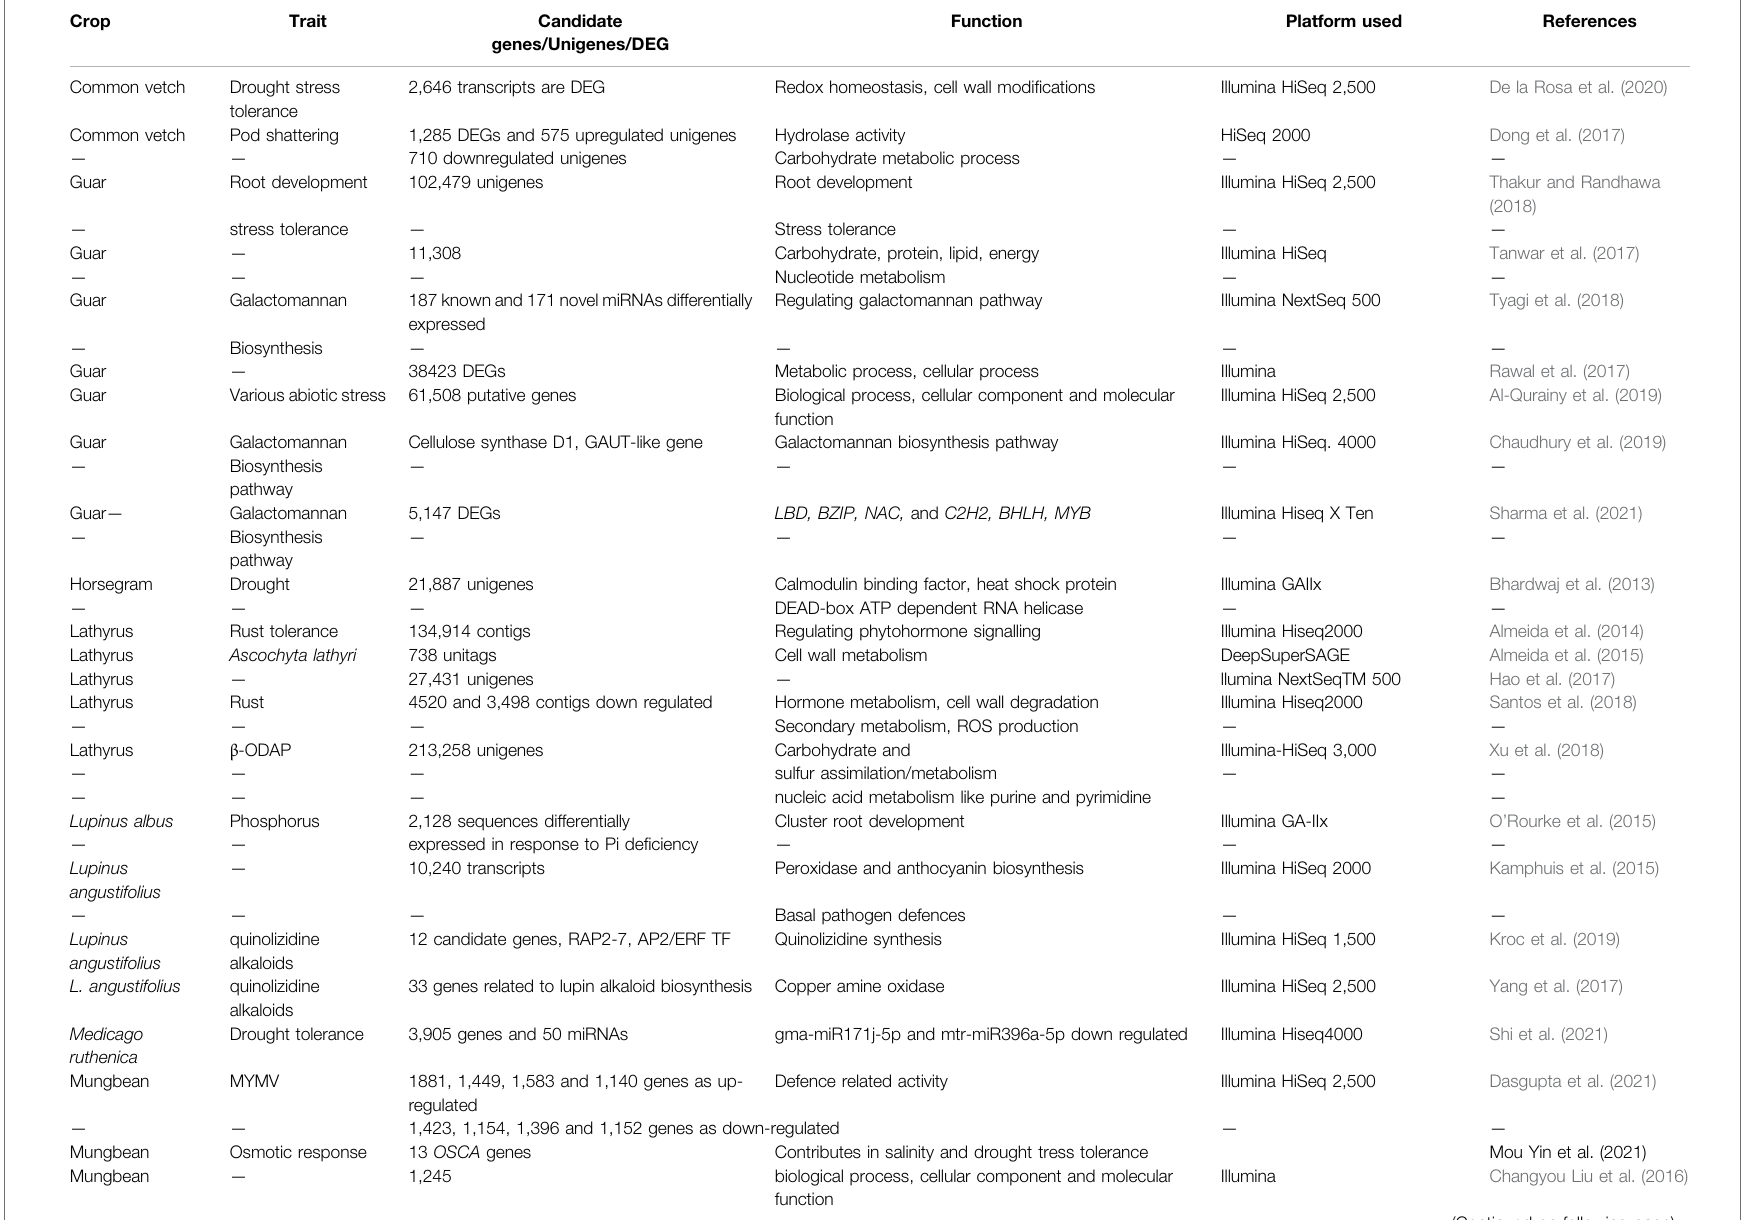
TABLE 6 | List of various differentially expressed genes/candidate traits genes with putative function in underutilised legumes.